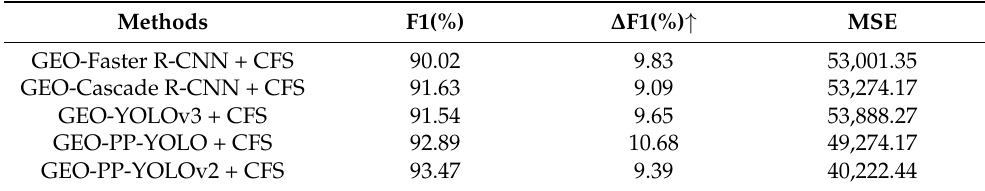
Table 3. Performance comparison of different deep models with